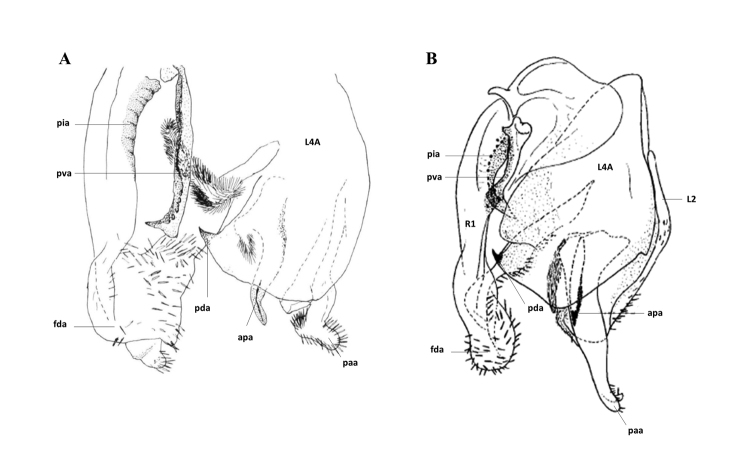
Genitalia: AGalepsus (S.) beieri (modified from Kaltenbach, 1996) BGalepsus (S.) birkenmeirae (modified from Beier 1969b). No scale. For abbreviations see Brannoch et al. (2017) and the text.